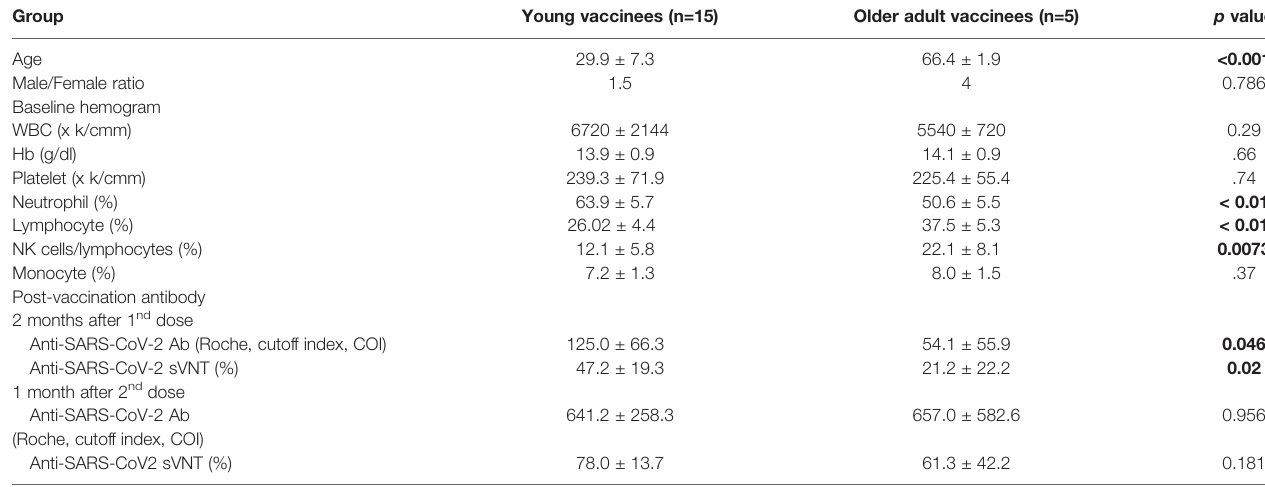
TABLE 1 | Demographic information, baseline hemogram, immune cells distribution and antibody response post vaccination of the vaccinees by age group.